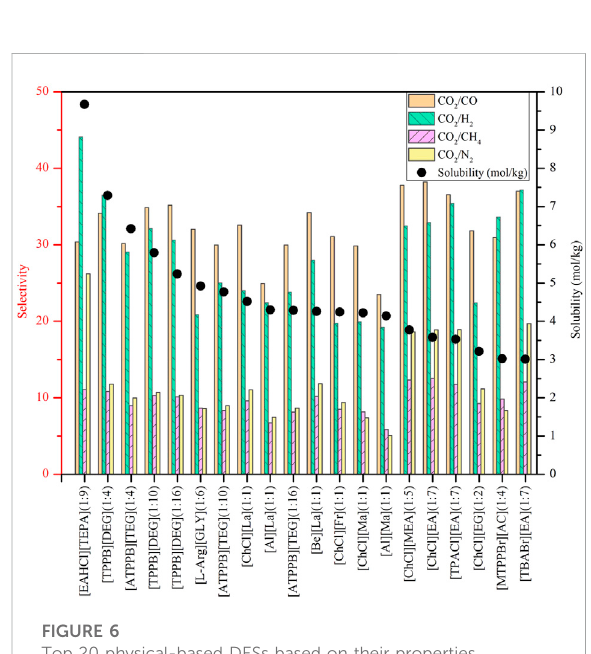
FIGURE 6 Top 20 physical-based DESs based on their properties.